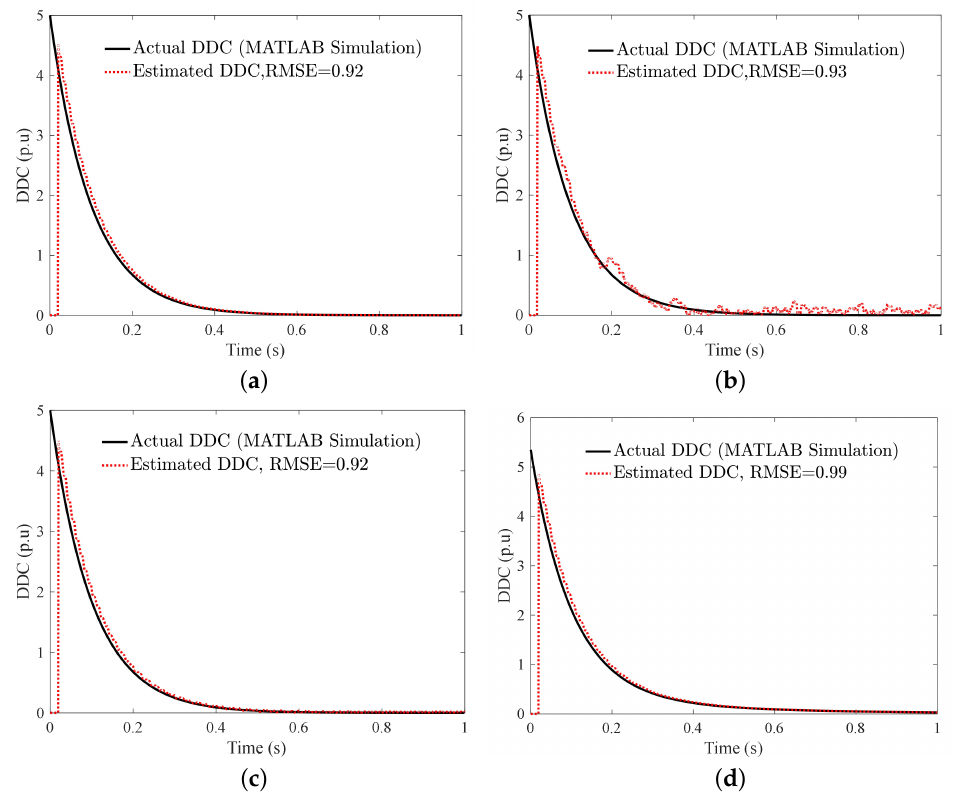
Figure 7. simulation results, method [7] (red line), under four different cases: ( a ) without noise, ( b ) in the presence of noise, ( c ) 0.5 Hz frequency deviation, ( d ) in the presence of the second DDC. In [2], a mimic filter was introduced to suppress the DDC effect on the FC